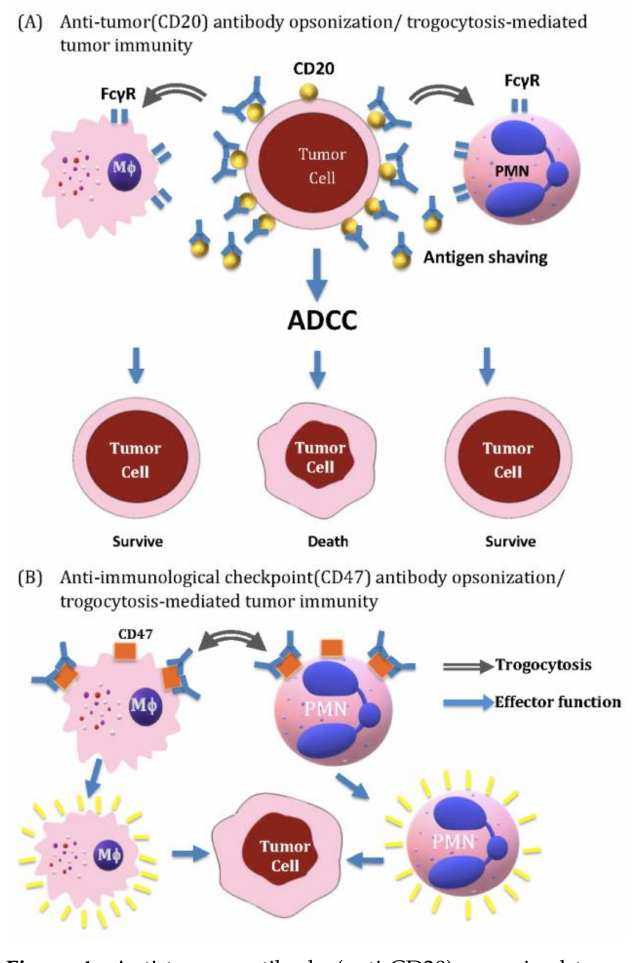
Figure 4. Anti-tumor antibody (anti-CD20)-opsonized tumor cells ( A ) and anti-immunological checkpoint antibody (anti-CD47)-opsonized innate immune cells ( B ) in mediating tumor immunol- ogy. ( A ) Anti-CD20 antibody can mediate tumor-killing activity by direct antibody-dependent cell-mediated cytotoxicity (ADCC). In addition, the anti-CD20 attached-CD20 antigens on tumor cells can be transferred to macrophages and PMNs via trogocytosis for further sensitization in both innate immune cells to augment their tumor-killing activity. However, the shaving of ani-CD20 attached- CD20 antigens from tumor cells decreases the tumor antigen density and may escape from further anti-CD20 antibody attack. ( B ) anti-CD47 blocking antibody can mediate tumor-killing directly by activating both macrophages and PMNs and be further augmented by mutual